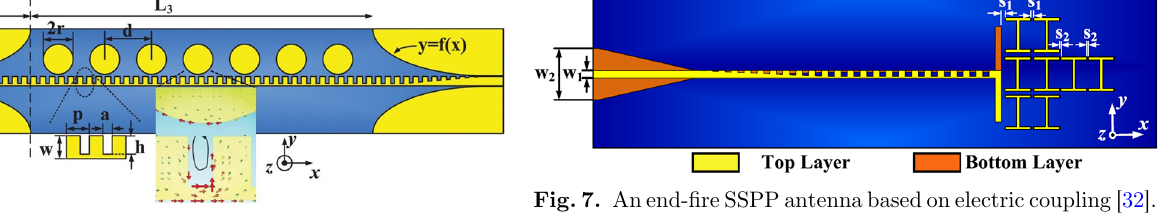
Fig. 5. An SSPP TL fed patch array with frequency-controlled broad-angle beam scanning [25]. The inset shows simulated electric current distribution at coupling part.